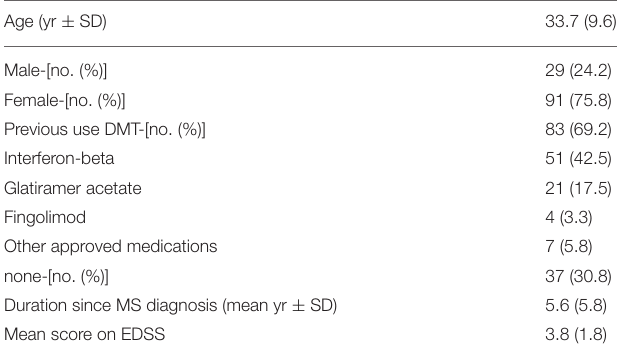
TABLE 1 | Baseline